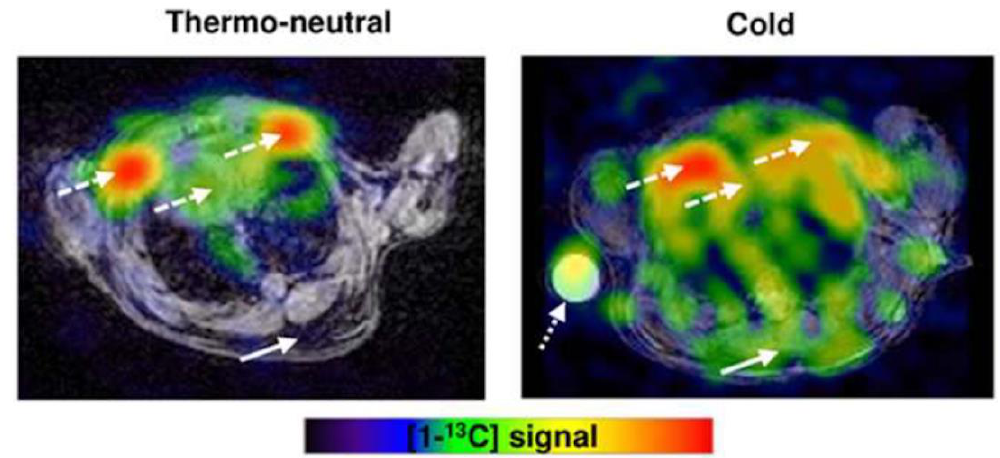
Figure 10. Hyperpolarized 13 C-pyruvate MRI with cold exposure in a mouse. Hyperpolarized 13 C-pyruvate MRI shows increased BAT activity in a mouse after cold exposure (solid arrow). The dashed arrows show the heart and large vessels and dotted arrow is a phantom. Image reproduced with permission from reference 92.